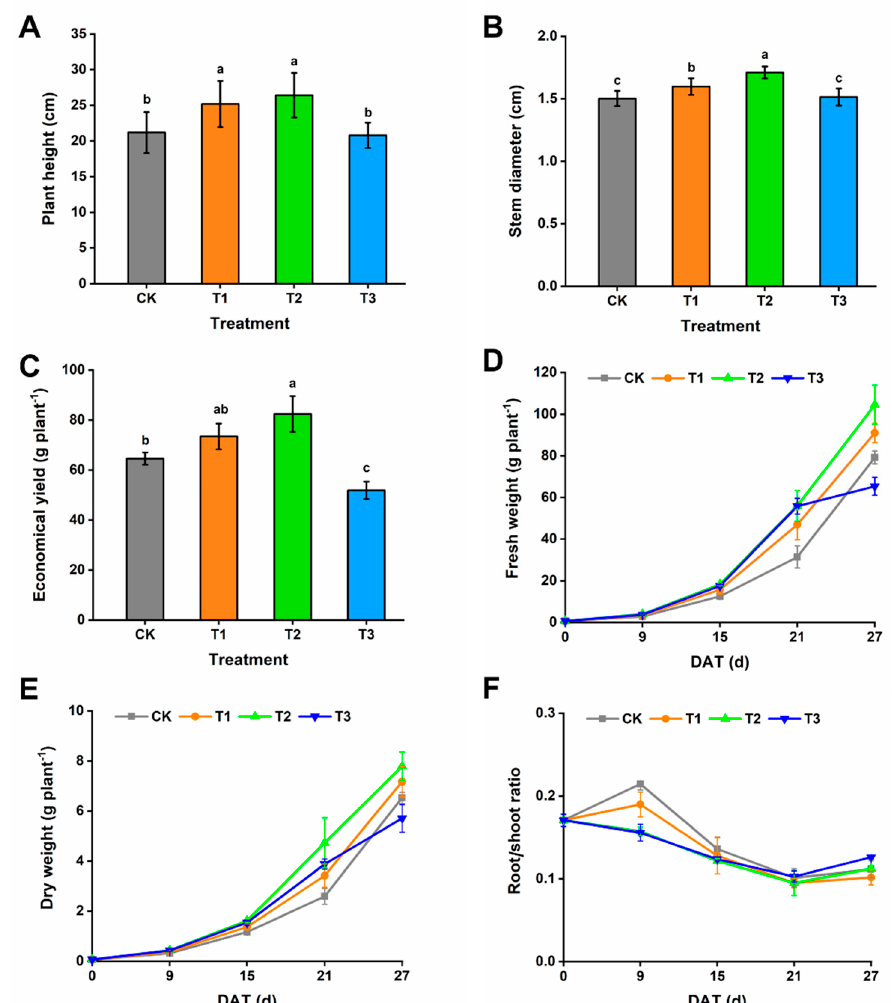
Figure 1. Effect of different NH 4 + /NO 3 − ratios on the growth and biomass of Chinese kale. ( A ) plant height at the harvest stage. ( B ) stem diameter at the harvest stage. ( C ) economical plant yield at the harvest stage. ( D ) dynamic changes in fresh weight. ( E ) dynamic changes in dry weight. ( F ) dynamic changes in the ratio of root to shoot fresh weight. CK = 0/100, T1 = 10/90, T2 = 25/75, T3 = 50/50. DAT, days after treatment. The data represent mean ± SE (n = 3). Different letters in Figure 1C–F indicate significant differences at p <